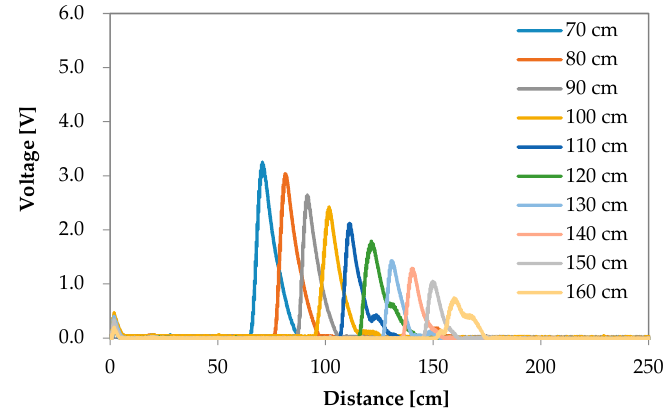
Figure 8. Experimental results of the reflection wave with respect to soil.